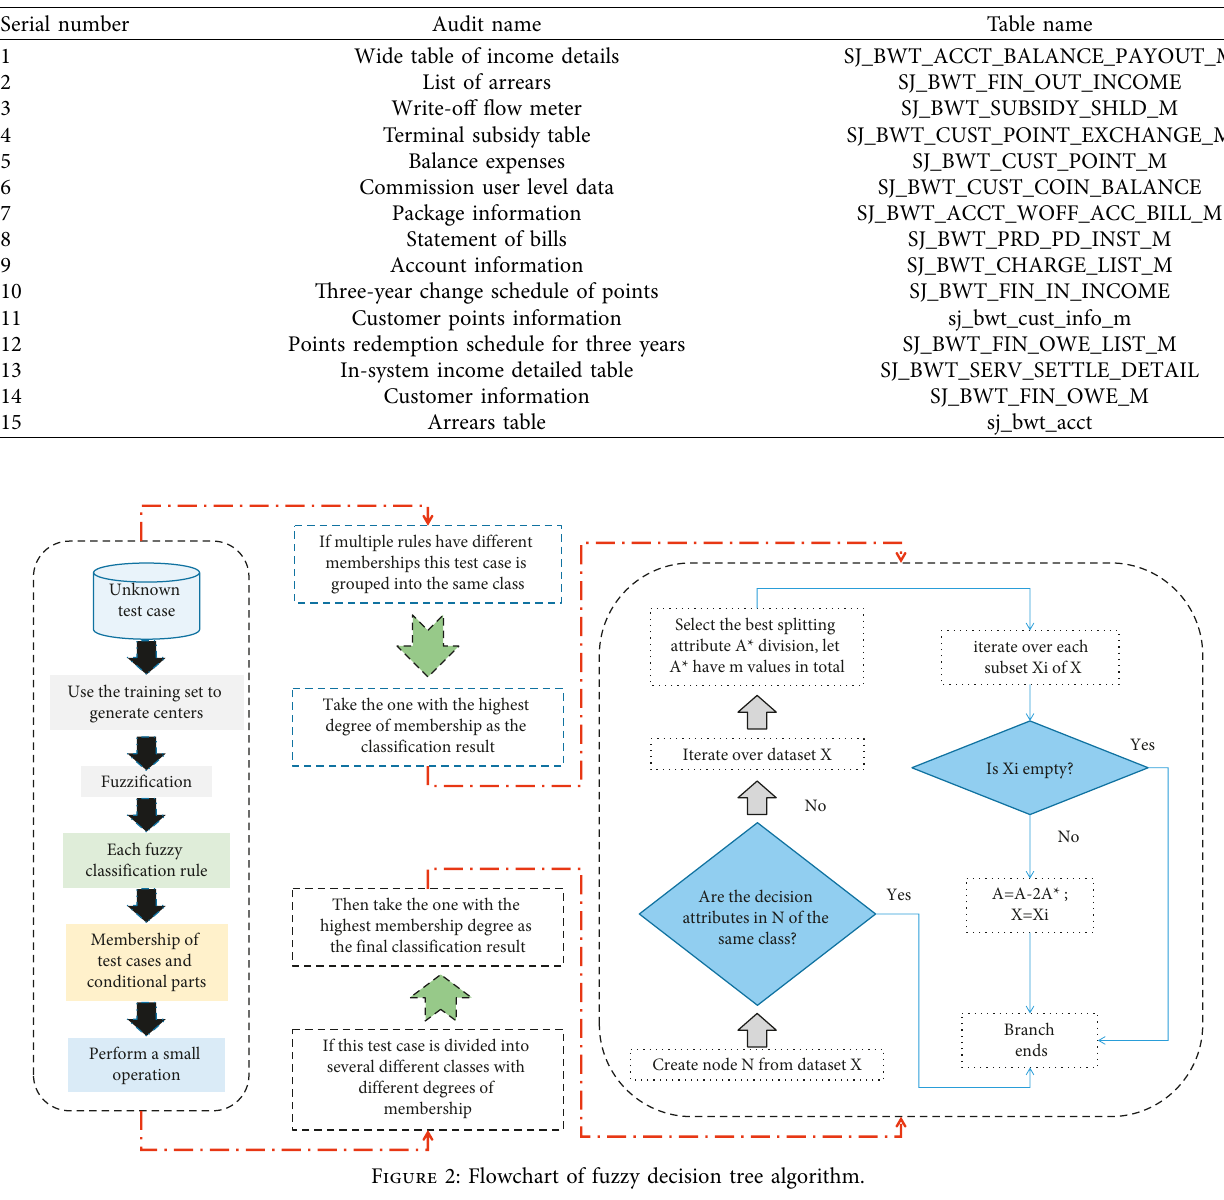
Table 1: Example of audit